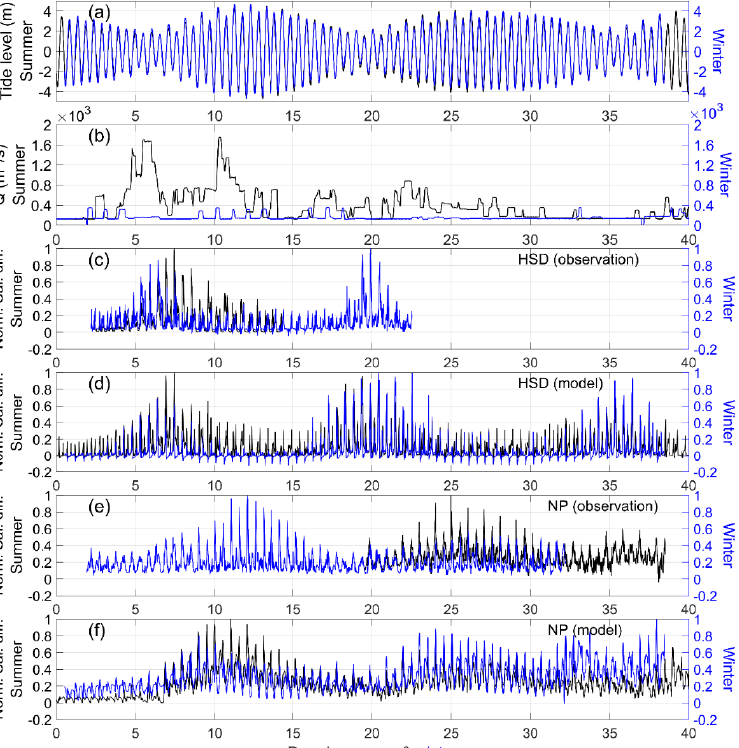
Figure 5. Normalized salinity differences between surface and bottom at HSD and NP, calculated from CTD data and model results. ( a ) Tides; ( b ) river discharge; ( c , d ) observed (calculated) salinity differences at HSD; and ( e , f ) observed (calculated) salinity differences at NP.